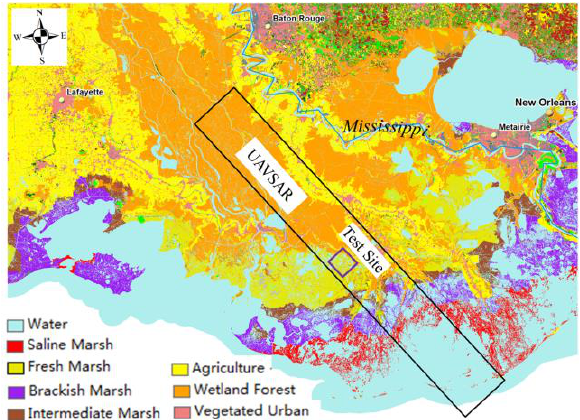
Figure 2. Thematic map, modified from GAP and 1990 USGS- NWRC classification results, showing the major land cover classes of the study area. Polygon represents extents of UAVSAR images shown in Table 1